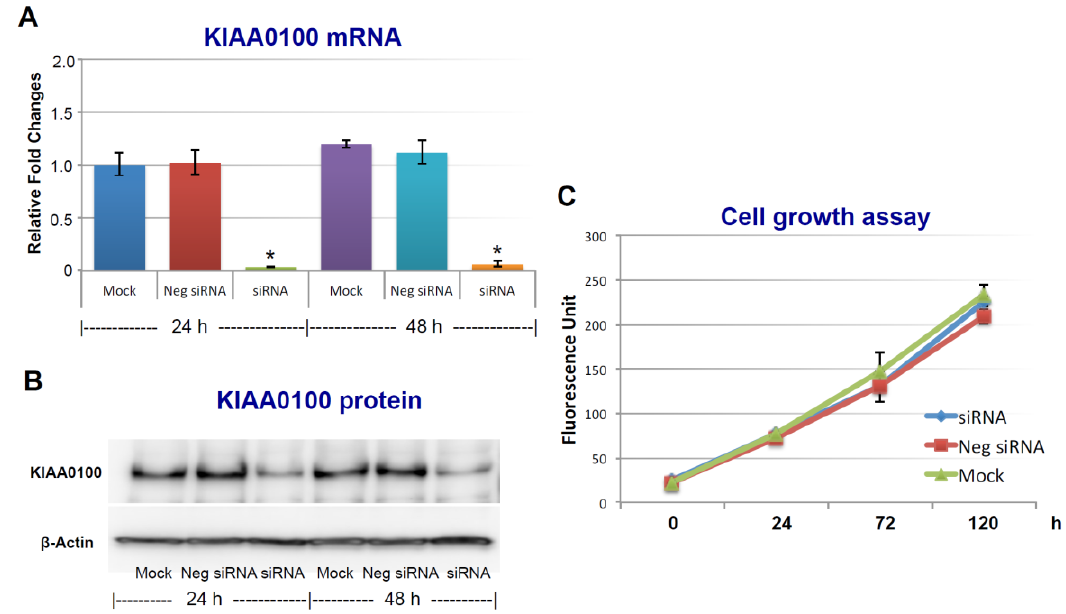
Figure 1. Silencing KIAA0100 expression does not affect cell anchorage-dependent growth/proliferation. MDA-MB-231 cells were first seeded on the culture plate and allowed to settle (attachment); cells were then transfected with KIAA0100 siRNA in a forward-transfection manner. Efficiency of the siRNA was examined by quantitative polymerase chain reaction (qPCR) and Western blot at 24 and 48 h after transfection. ( A ) Relative KIAA0100 mRNA expression was analyzed by ΔΔCt analysis; mock control at 24 h was used as reference group and the β-actin was used as reference gene. Y-axis is relative expression level indicated as fold changes in reference to the mock sample at 24 h. Cells transfected with negative siRNA showed little reduction in KIAA0100 mRNA expression level compared to mock controls ( p > 0.05); KIAA0100 siRNA treatment significantly reduced the KIAA0100 mRNA expression level by over 90% in the first 24 h and 48 h (*, p < 0.05); ( B ) KIAA0100 protein levels detected by Western blot. Consistent with the reduction in the mRNA level, protein level of KIAA0100 significantly decreased within 24 and 48 h, compared to the mock controls and cells treated with negative siRNA; ( C ) cell growth/proliferation were examined by multiTox-Fluor cell viability assay from day 0 to day 5, assay was performed every two days. No significant difference was observed in the cell proliferation/growth of the cells treated with KIAA0100 siRNA and the negative siRNA as well as the mock controls ( p > 0.05).